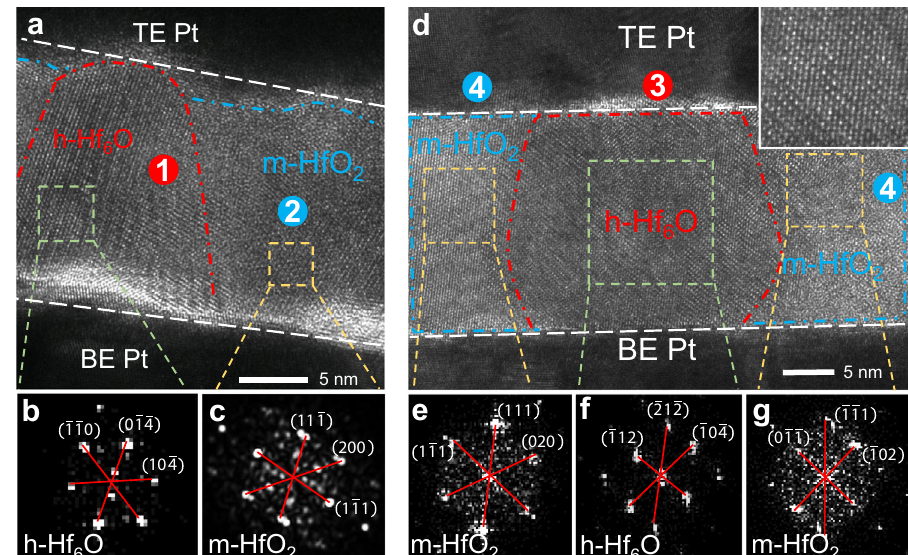
Fig. 2 Complete CFs and their m-HfO 2 shells in the LRS of Pt/HfO 2 /Pt RS memristors. a HRTEM of a complete CF in the LRS device operated under 0.1 mA I CC with the typical polymorphous HfO x region, namely, h-Hf 6 O and m-HfO 2 region, as con fi rmed by their FFT diffraction patterns in b and c . d HRTEM of the CF in the LRS memristor operated under 1 mA I CC , where the h-Hf 6 O CF is enclosed by the nonconductive m-HfO 2 shell, as con fi rmed by their FFT diffraction patterns in e – g . The inset of d is the high-resolution close-up view of the h-Hf 6 O CF region marked with a green square.